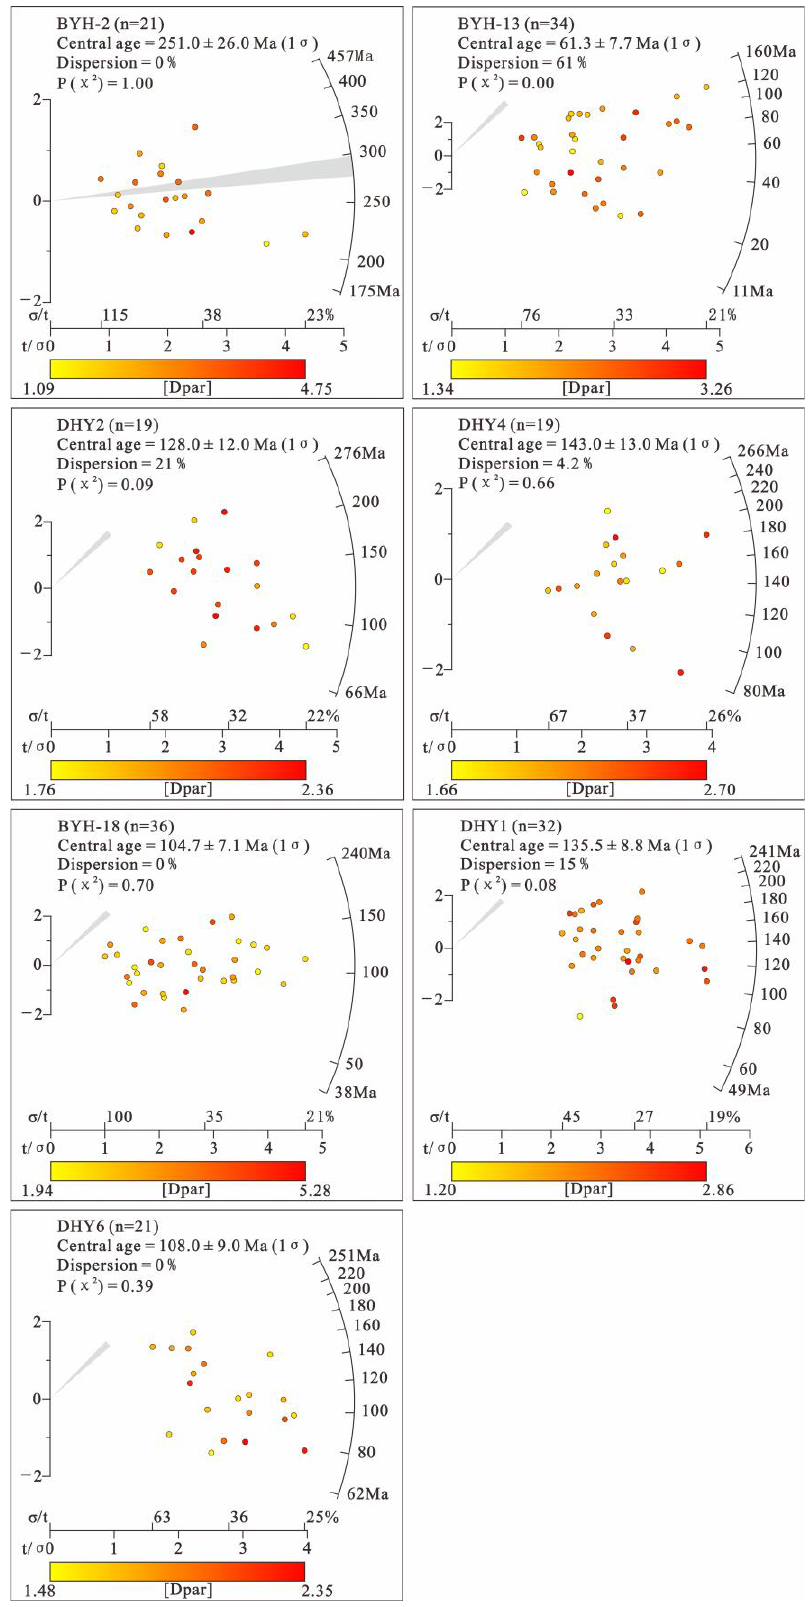
Figure 3. Radial plots for samples from the Bogda. Radial plots were constructed using the Radial Plotter program in [38]. The gray area corresponds to stratigraphic or crystallization age.